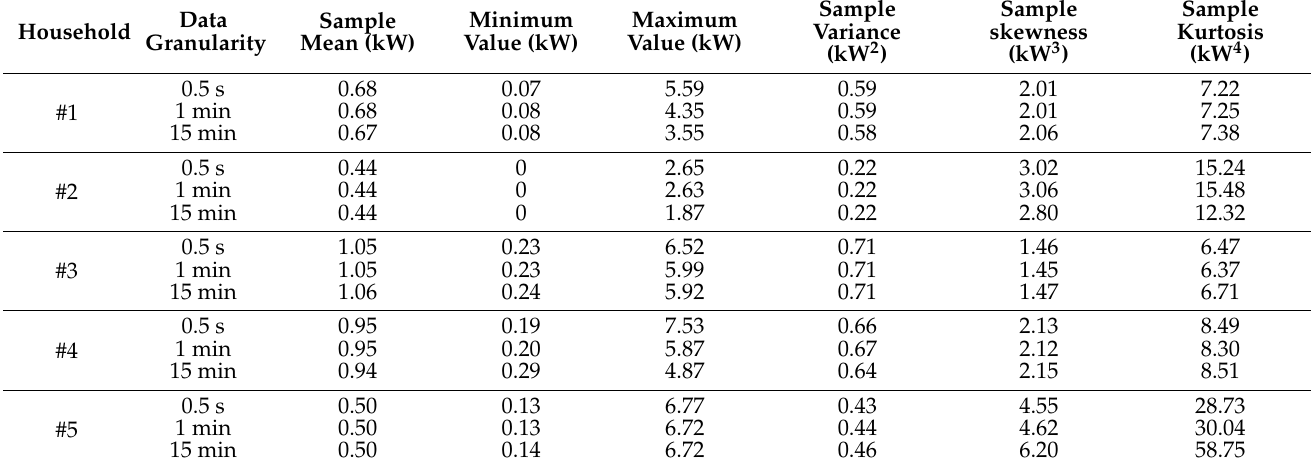
Table 8. Descriptive statistics of the consumption load profile throughout the year.